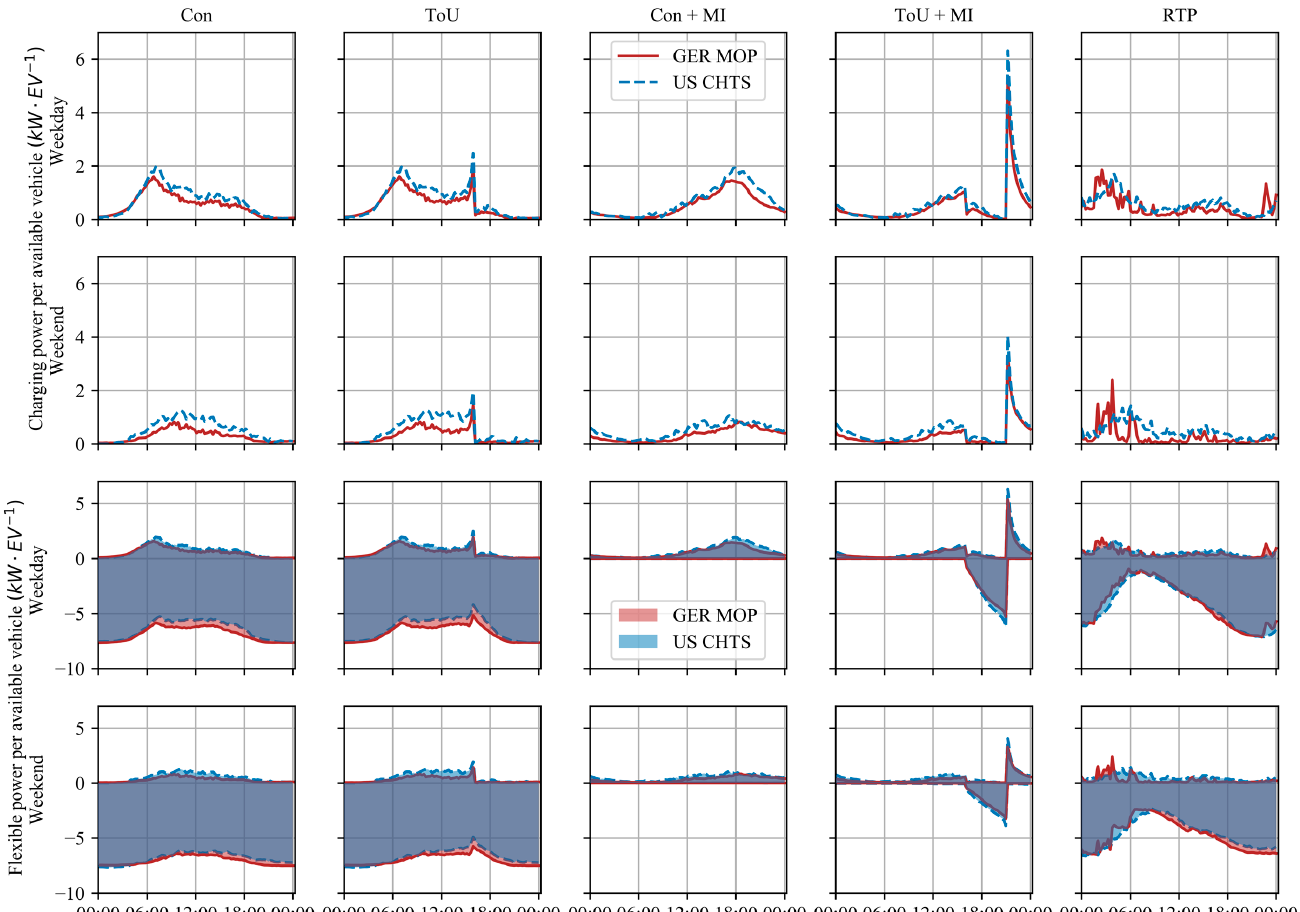
Figure 7. The plot series visualizes the charging and flexible power per available EV. The first two rows of plots show the charging power per available EV for the five operating strategies on weekdays and weekends. The third and fourth rows of plots show the flexible power per available EV for the five operating strategies on weekdays and weekends.